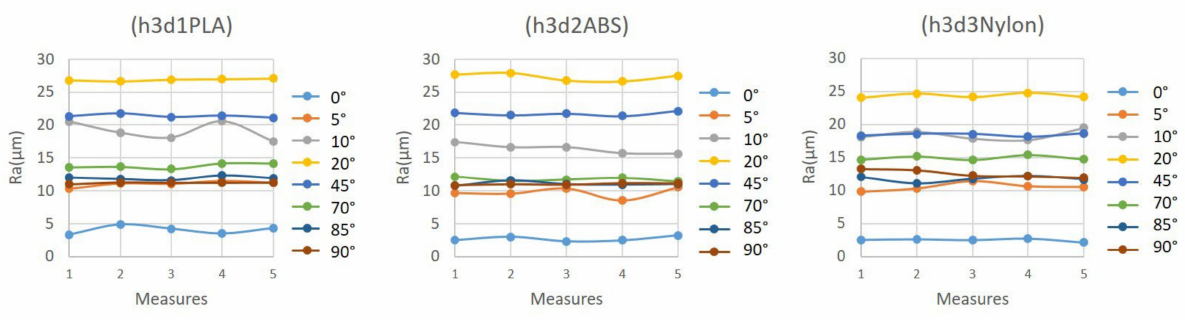
Figure 5. Ra values measured on eight angles of specimens h3d1PLA, h3d2ABS and h3d3 nylon. Standard deviations were also reduced, with the exception of occasional cases where models were not clearly defined and had values that reached a maximum of 1.45 µ m (Figure S2). Initially, it was expected that due to the predictable roughness value in the horizontal plane (0 ◦ ), it would increase up to the maximum value in the vertical plane, since this angle (90 ◦ ) should have presented greater deviations when the roughness measurement was perpendicular to the deposition plane and to the elliptical section considered, always showing a greater depth in the spaces generated between layers. However, once the results were analyzed, in all cases studied, which were very different from each other, shape relationship values between nozzle diameter and layer height of 1.67 up to 13.33 were achieved, and a maximum roughness value of 20 ◦ was obtained, regardless of the combination of layer height, nozzle diameter and material (Figures 6, 7, S3–S5 and Table S7).